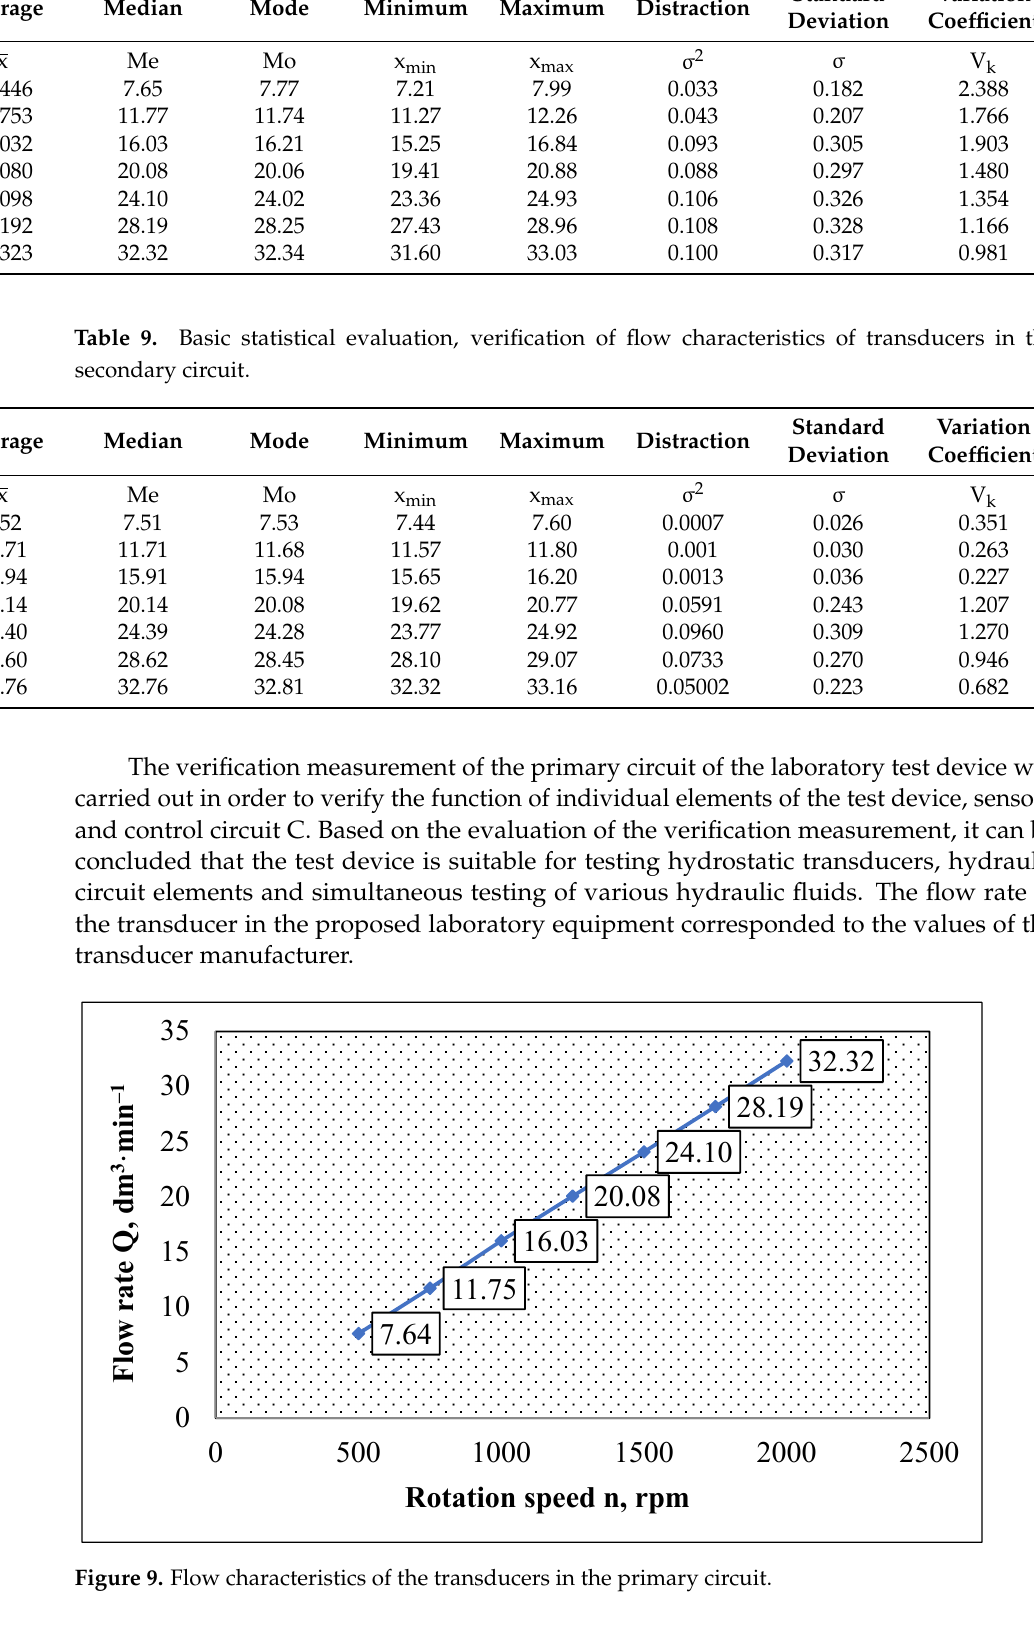
Table 8. Basic statistical evaluation, verification of flow characteristics of transducers in the primary circuit.